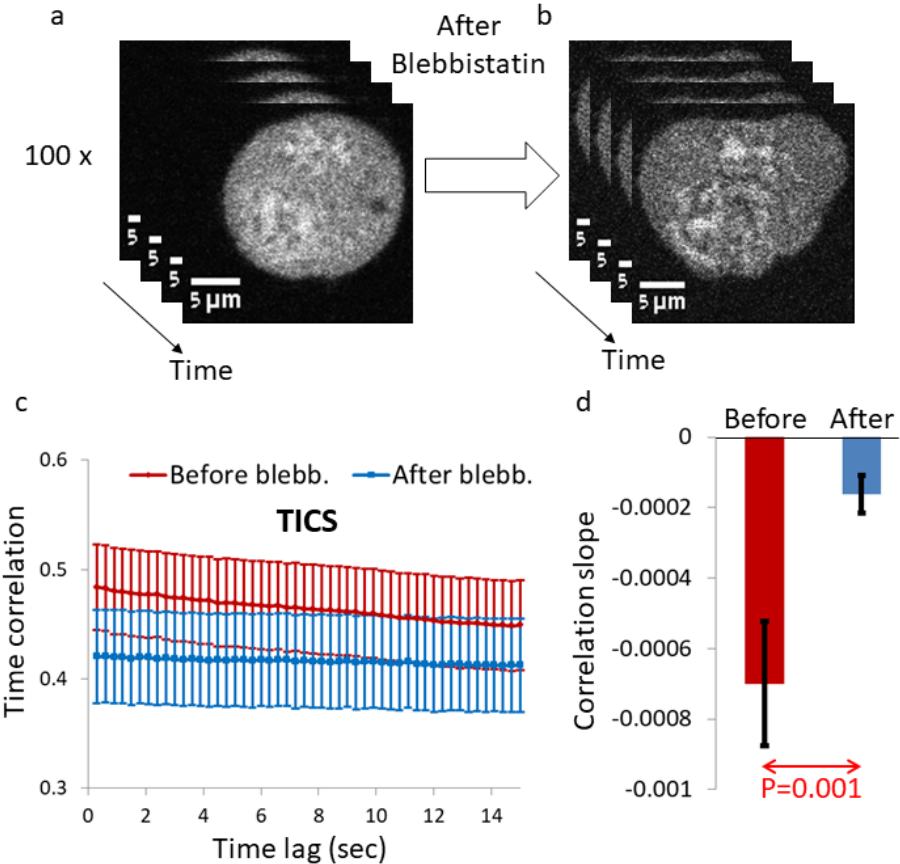
Figure 3. Temporal image correlation spectroscopy (TICS) in live cells highlighted with Ca ++ -Fluo-4 before and after blebbistatin treatment. ( a ) Multiple time-dependent images of a Ca ++ -Fluo-4-highlighted cell before blebbistatin treatment. ( b ) Multiple time-dependent images of a Ca ++ -Fluo-4-highlighted cell after 10 µ M blebbistatin treatment. ( c ) The average TICS results for the cells (N = 31) before blebbistatin treatment and for the same cells after 10 µ M blebbistatin treatment. ( d ) The average correlation slope in cells before blebbistatin treatment, in comparison to the average correlation slope in the same cells after blebbistatin treatment. Error bars are SEM and p -value is shown in ( d ).